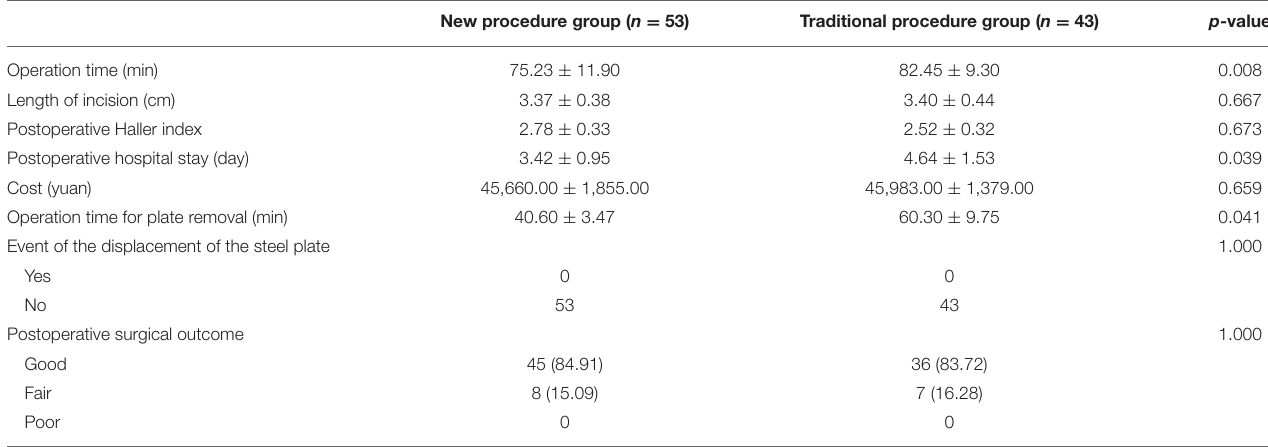
TABLE 2 | Comparison of surgical characteristics between new procedure and traditional procedure group. New procedure group ( n =